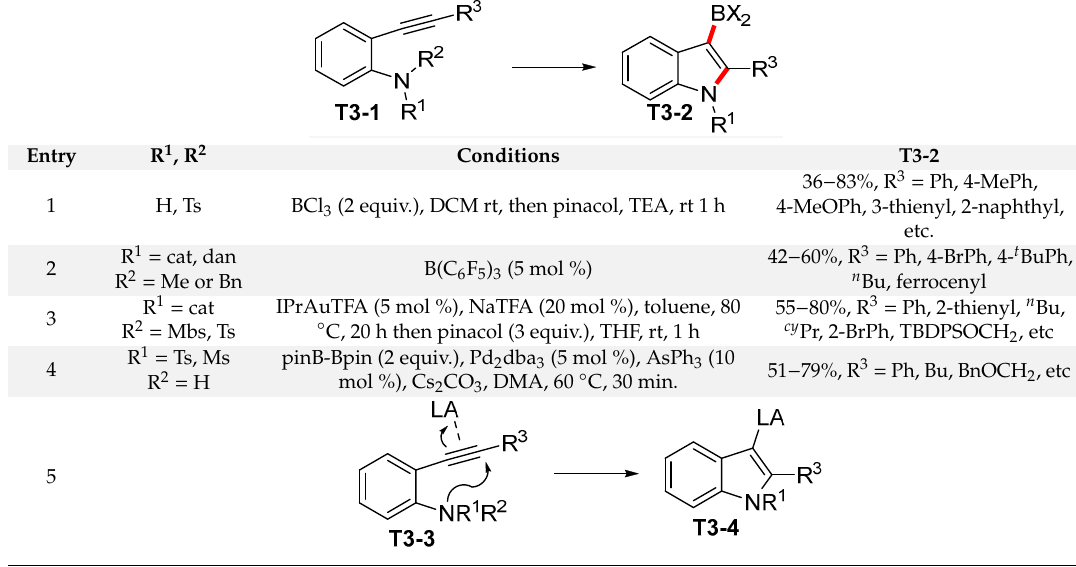
Table 3. The synthesis of indolylboronic acids or esters via the cyclization of substituted anilines.